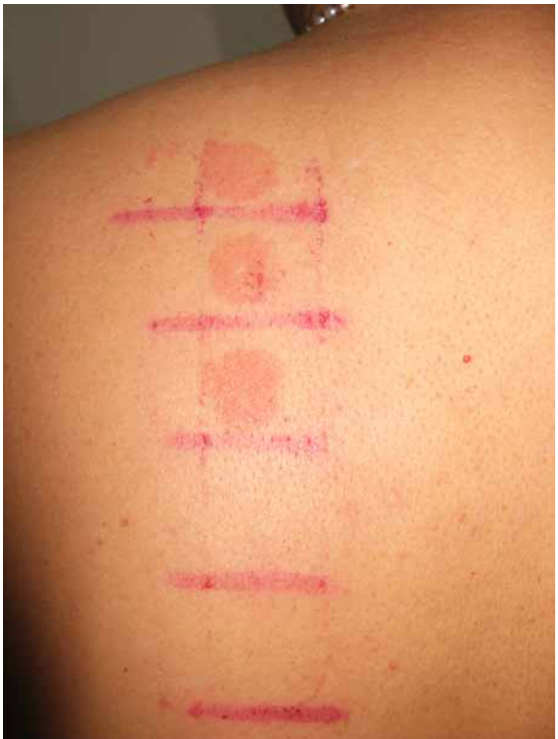
Figure 3. Positive result of PT with tribenoside. Glyvenol at 30% in alcohol: ++, Glyvenol at 30% in petrolatum: ++, Glyvenol